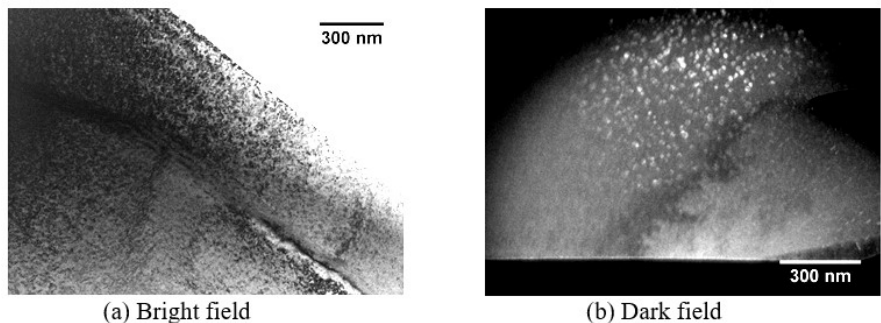
Figure 6. TEM images of Inconel 718 crept at 700 °C and 700 MPa.